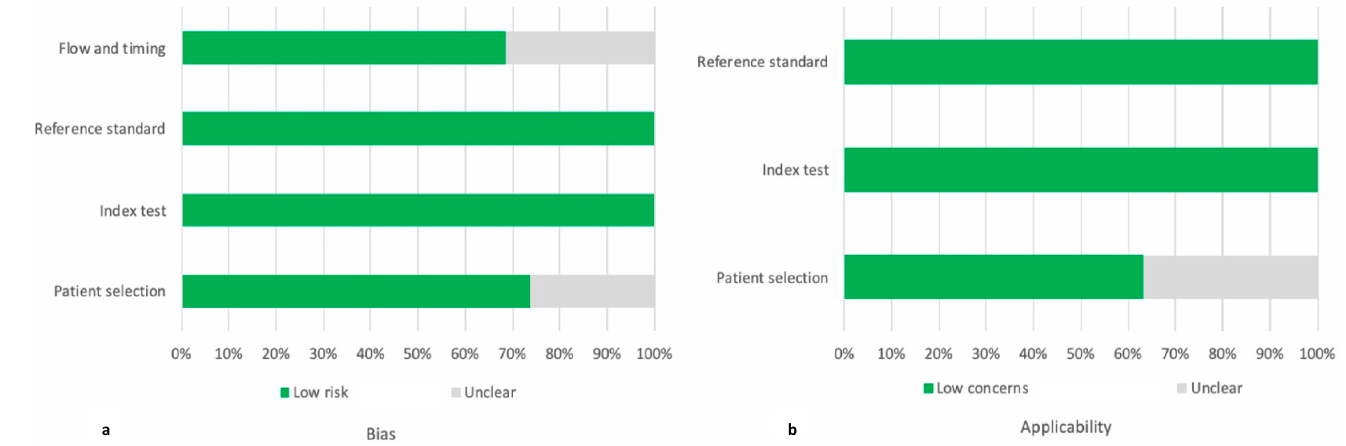
Figure 1. Assessment of the risk of bias ( a ) and the applicability ( b ) through the QUADAS-2 score. Rudnicki et al. [16] recently compared MRI and CEM in 121 patients with dense breast and abnormalities detected upon ultrasound (US) or mammography (MG). The CEM accuracy and specificity were higher (77% vs. 74 and 33% vs. 23%, respectively) compared with MRI in this cohort of females with dense breasts. Luczynska et al. [17] focused on evaluation of the background parenchymal enhancement (BPE) in addition to the qualitative assessment as a potential method to add value to both CEM and MRI. They analysed 64 patients. Strong BPE was more frequent among malignant lesions than benign ones for CEM, providing added value to the sole qualitative description of the lesion enhancement level.